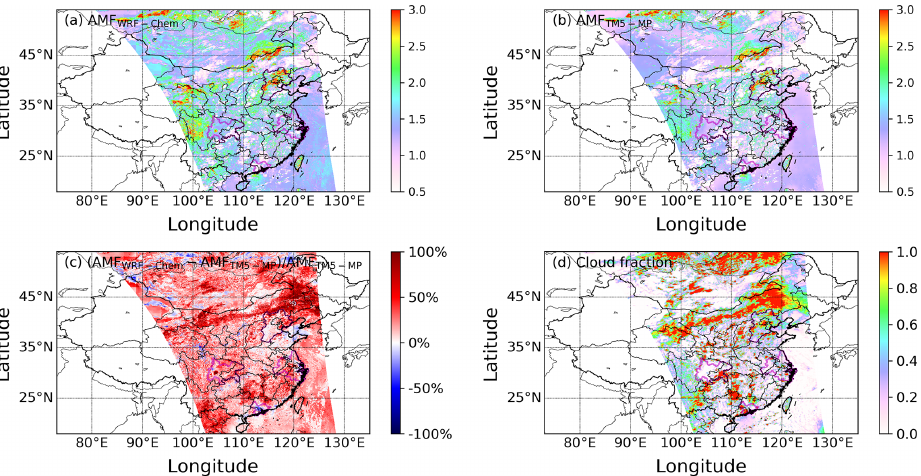
Figure 9. Spatial distributions of AMFs calculated using WRF-Chem (a) and TM5-MP (b) simulations as a priori HCHO profiles of orbit 04211 on 6 August 2018. Spatial distribution of difference of the AMFs (c) and of cloud fraction (d) of orbit 04211 on 6 August 2018.